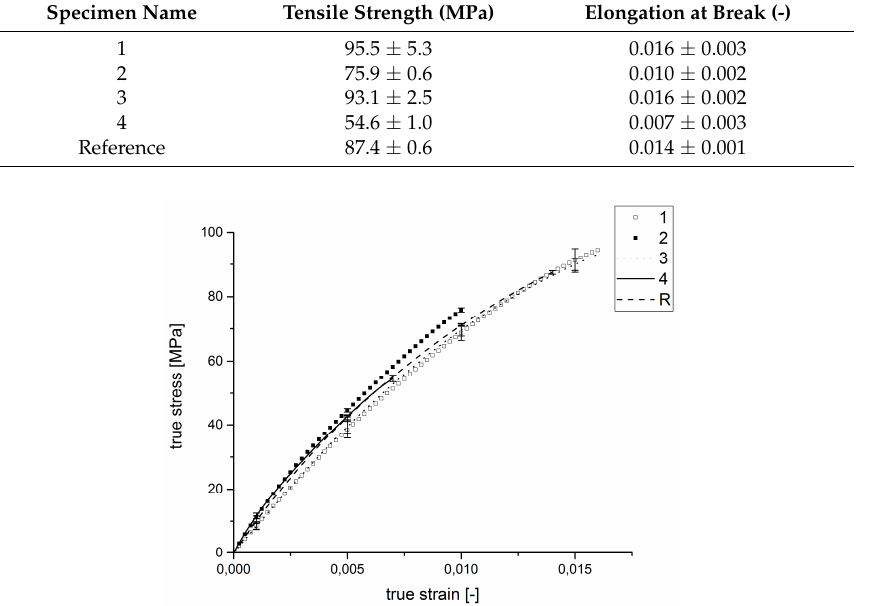
Figure 12. Average stress-strain diagram of the tensile tests for the samples influenced by the injection molding parameters.